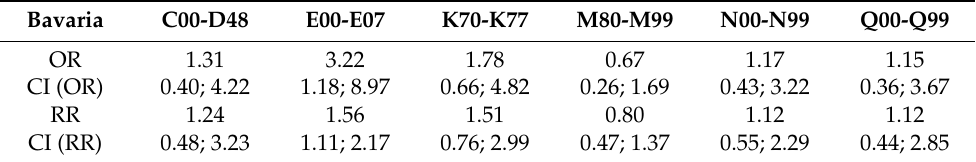
Table 4. Odds ratio (OR) and relative risk (RR) calculations using mean drinking water U concentration >2 µ g/L as risk factor. 95% CI: 95% confidence intervals (lower and upper limit). Bavaria C00-D48 E00-E07